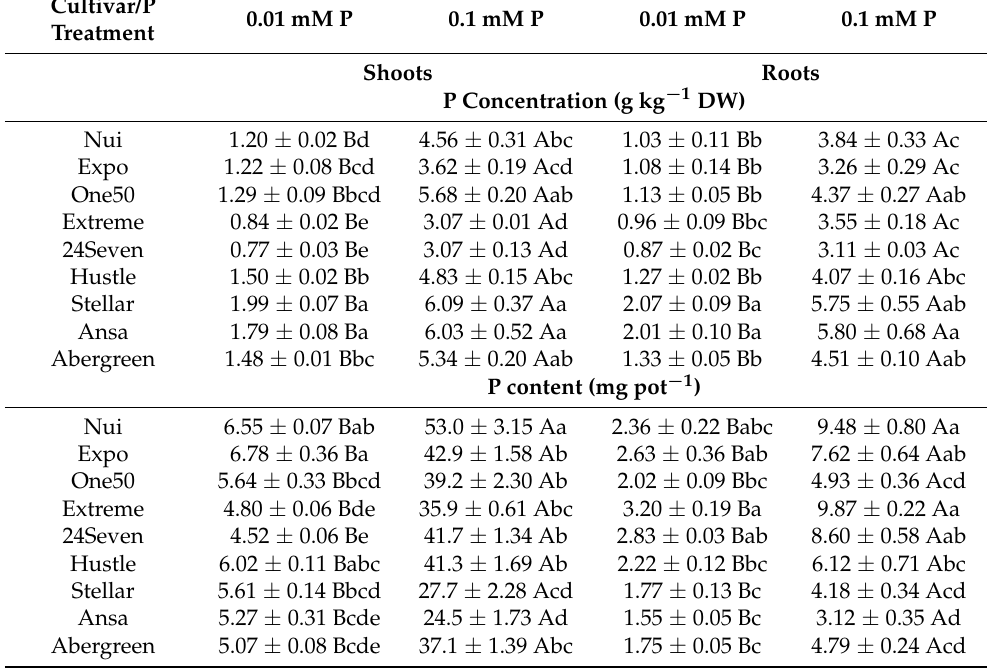
Table 1. Phosphorus (P) concentrations and P content in shoots and roots of different ryegrass cultivars hydroponically grown at optimal (0.1 mM P) and deficient (0.01 mM P) P conditions. Values represent the mean (n = 3) ± standard error. Different uppercase letters indicate statistically significant differences (Tukey’s HSD at p ≤ 0.05) between P treatments for the same cultivar. Different lowercase letters indicate statistically significant differences (Tukey’s HSD at p ≤ 0.05) among ryegrass cultivars at the same P